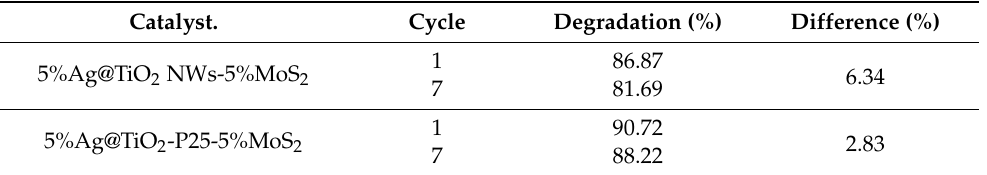
Table 4. Degradation and difference percentages of the 5%Ag@TiO 2 NWs-5%MoS 2 and 5%Ag@TiO 2 - P25-5%MoS 2 catalysts after seven cycles. Catalyst. Cycle Degradation (%) Difference (%) 1 5%Ag@TiO 2 NWs-5%MoS 2